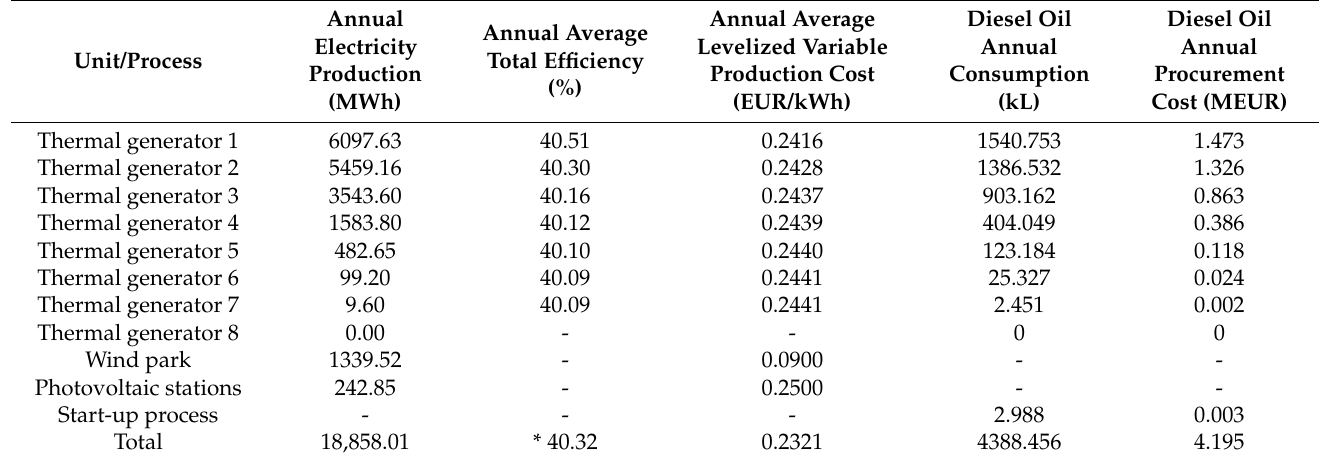
Table 2. Analysis of the annual electricity production on Sifnos in 2021.